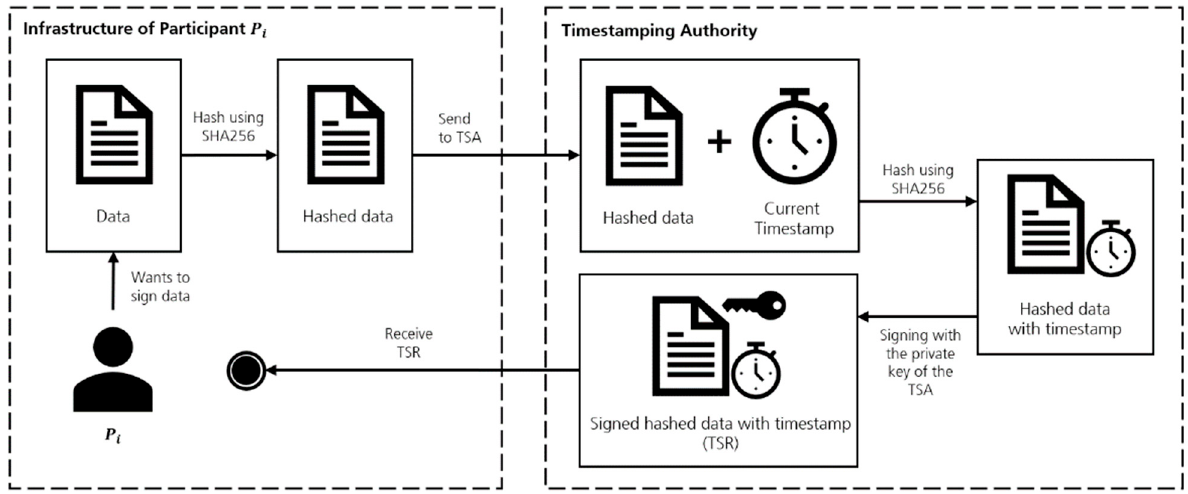
Figure 1. Timestamping process between a requester and a TSA [41].